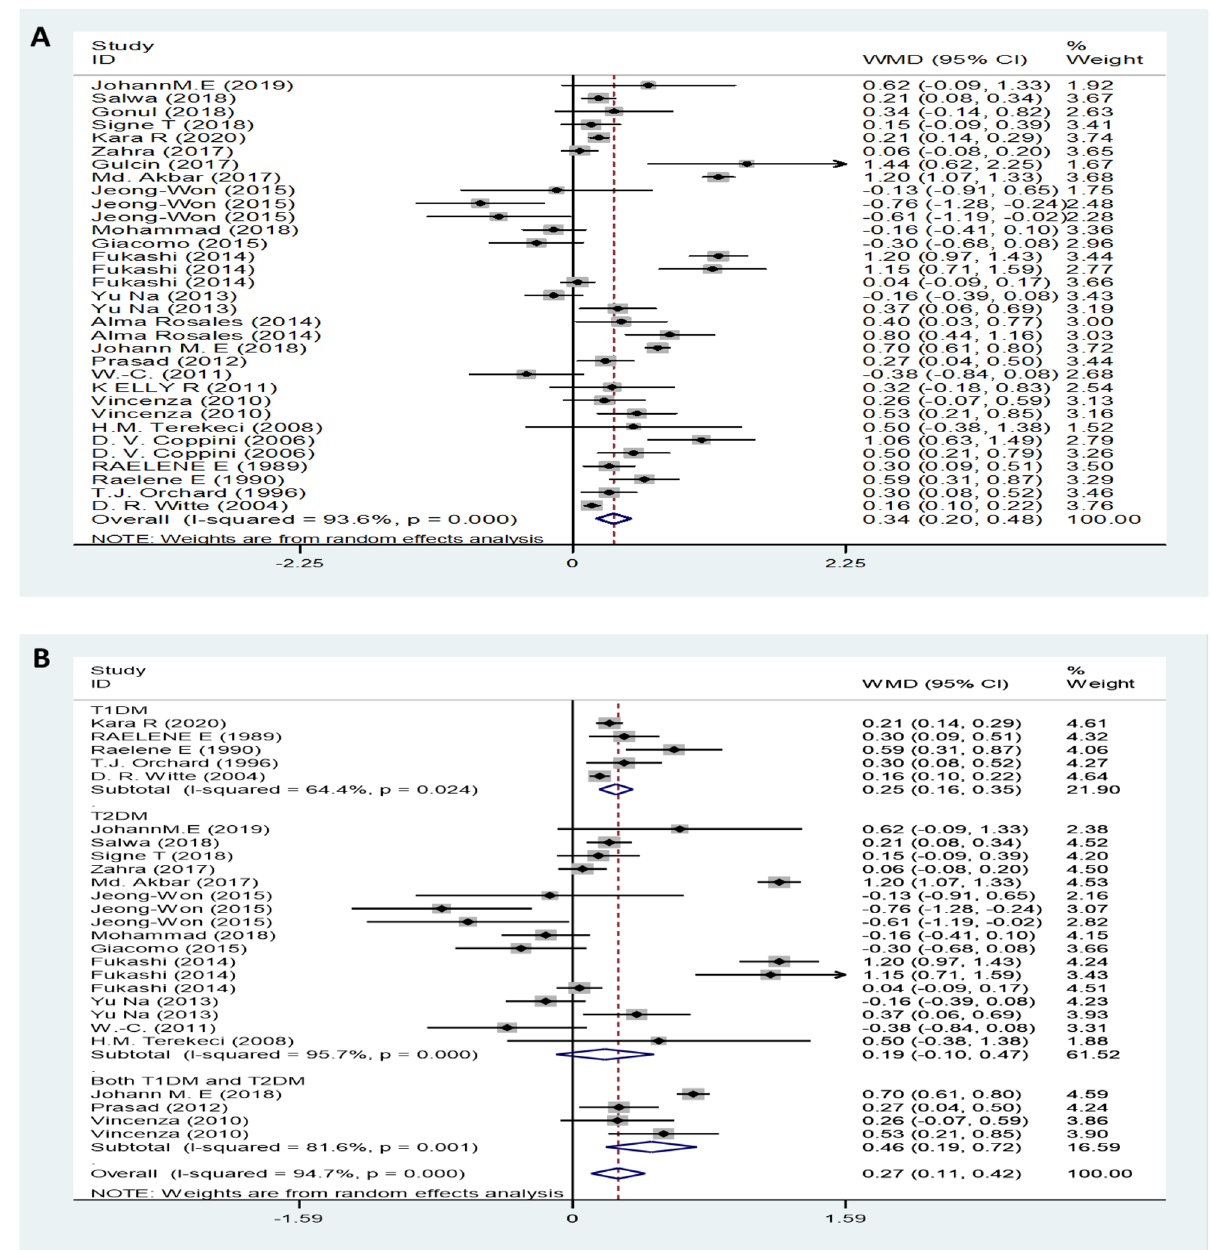
Figure 2. TG levels ( A ) in people with DN versus those without DN. TG levels in the subgroup analysis stratified by the type of diabetes ( B ) and symptom severity ( C ). OR ( D ) for DN in patients according to serum TG